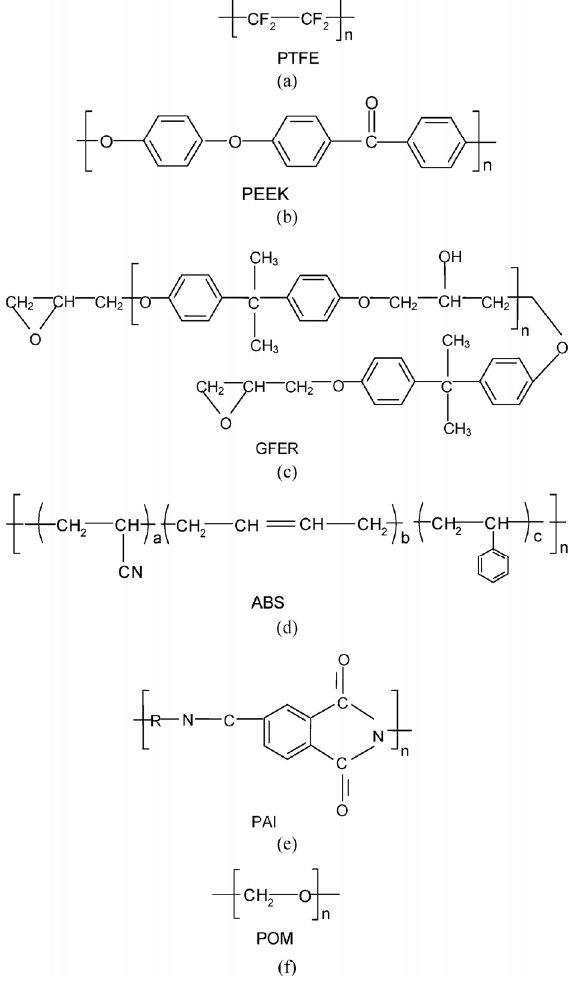
Fig. 9 Molecular structure of (a) PTFE, (b) PEEK, (c) GFER, (d) ABS resin, (e) PAI, and (f)